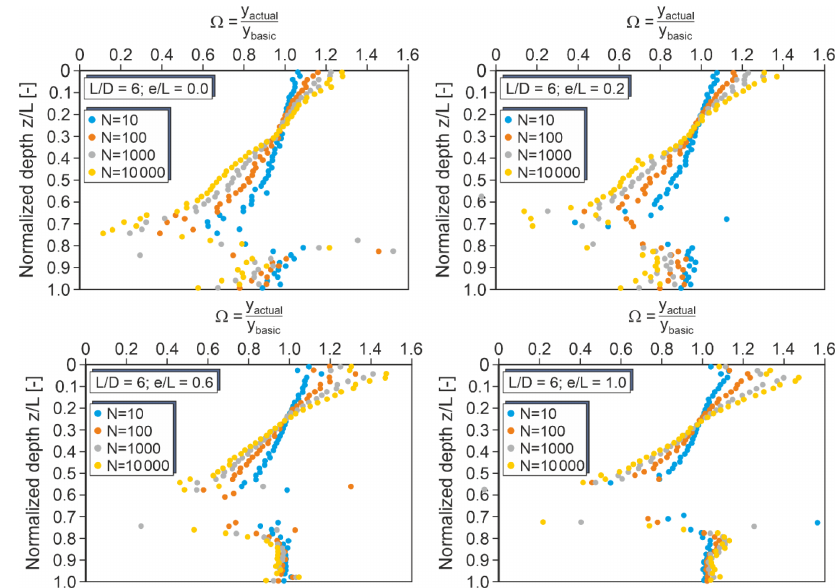
Figure 11. Correction factors (cid:127) for monopiles with L/D = 6 and different load eccentricities (very dense sand).